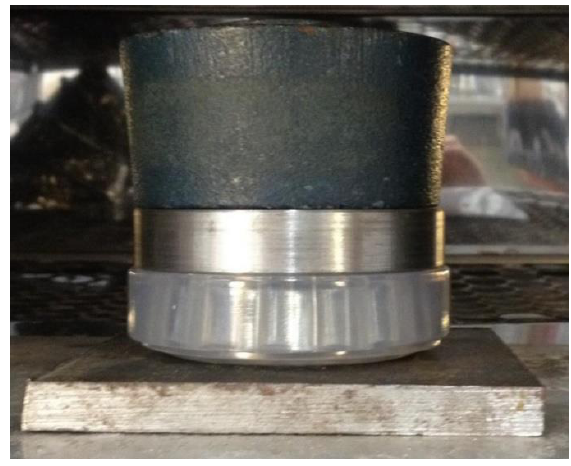
Figure 2. Freezing of stresses-prototyped model in stereolithography.